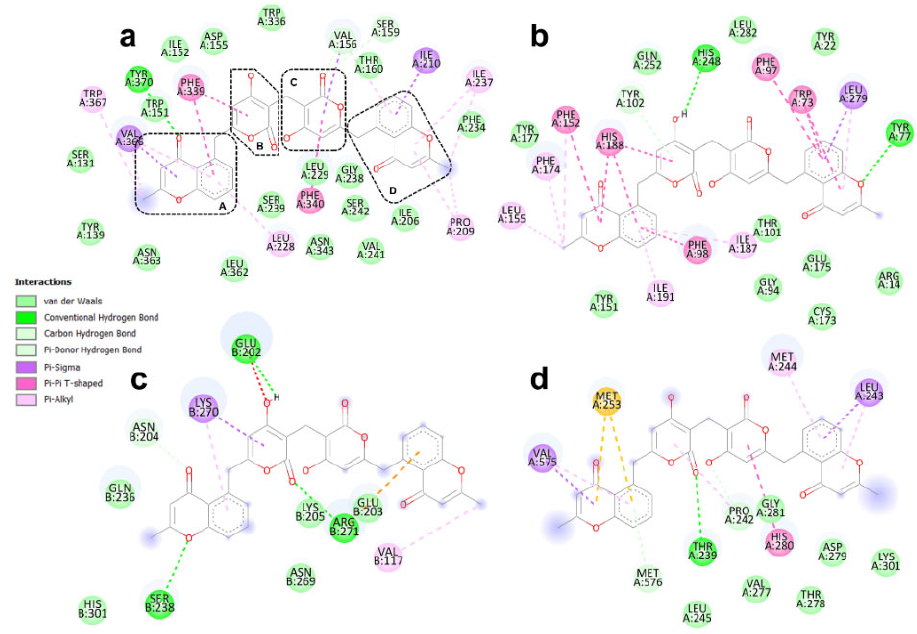
Figure 10. Receptor–ligand interactions of phaeochromycin F ( A3 ). The interactions between phaeochromycin F and the residues involved in the binding sites for ( a ) 5-HT 2A ; ( b ) PAF-R; ( c ) IL-1R1; ( d ) EGF-R are shown. In ( a ), the phaeochromycin F substructures are indicated as follows: A and D represent the 4 H -chromen-4-one moiety; B and C represent the 2 H -pyran-2-one moiety. The color legend indicates the type of interaction. Green colors represent H ‐ bond ‐ type interactions, and pink − purple colors are used for hydrophobic interactions. In IL ‐ 1R1 ( c ), yellow color indicates cation ‐π electrostatic interaction. In EGF ‐ R ( d ), yellow color indicates π‐ sulfur interaction.